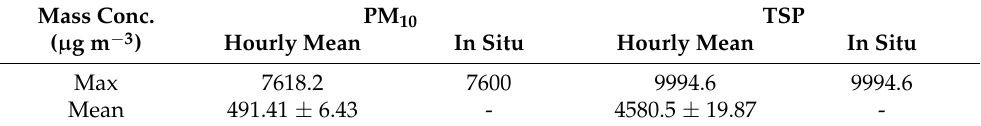
Table 1. Hourly and in situ means of PM 10 and TSP in Tazhong from 1 July to 31 August 2019. Mass Conc. PM 10 TSP ( µ g m − 3 ) Hourly Mean In Situ Hourly Mean In Situ Max